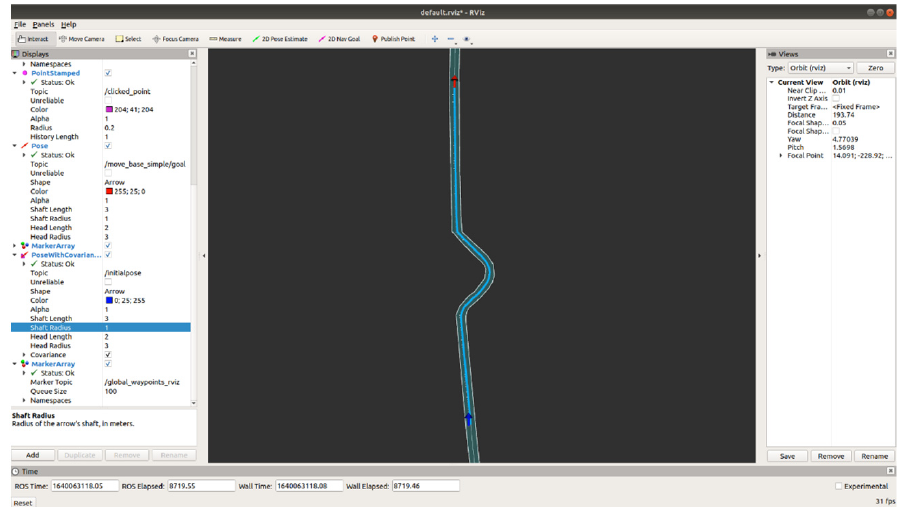
Figure 14. The process of incorporating high dynamic map data into an autonomous vehicle.